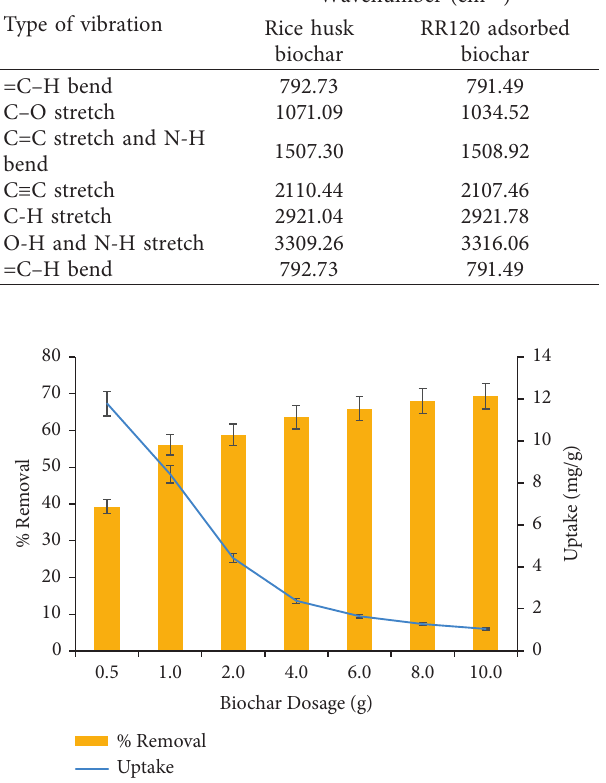
Figure 3: Effect of biochar dosage on the sorption capacity and RR120